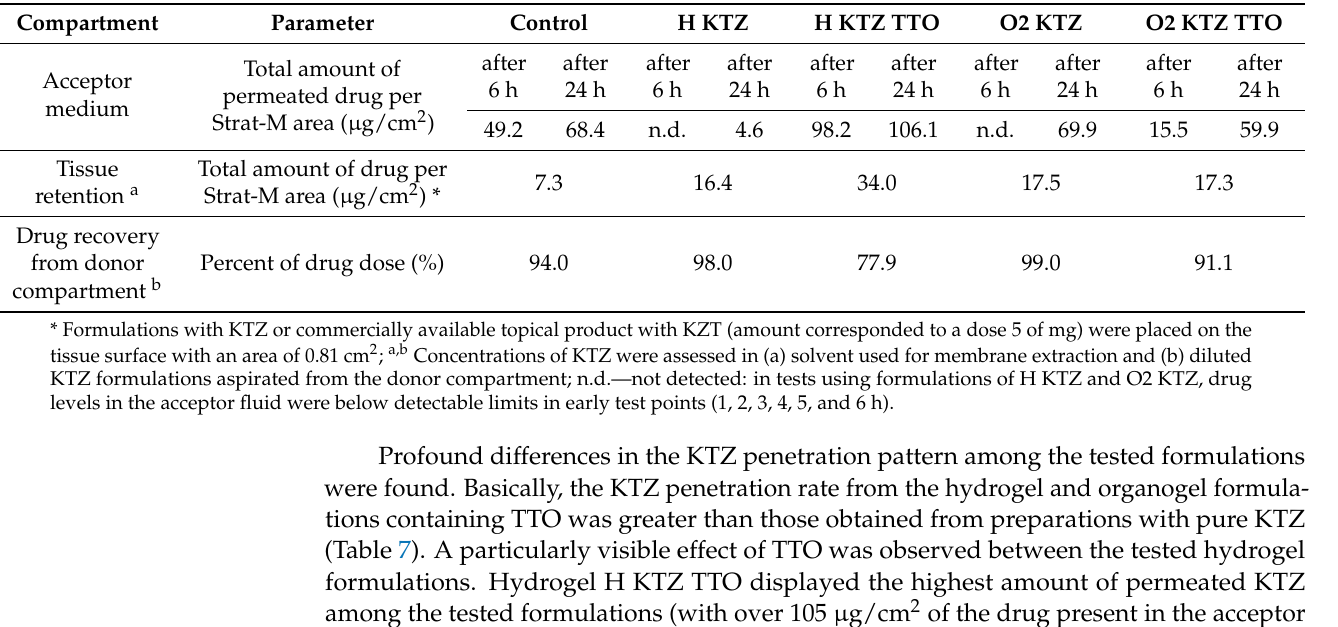
Table 7. Quantitative analysis of KTZ from hydrogels and organogels with KTZ or combination of KTZ and TTO as compared to control (commercially available topical product with KTZ) in acceptor medium, retained in the Strat-M and on the membrane surface (drug recovery from donor compartment) after 24 h